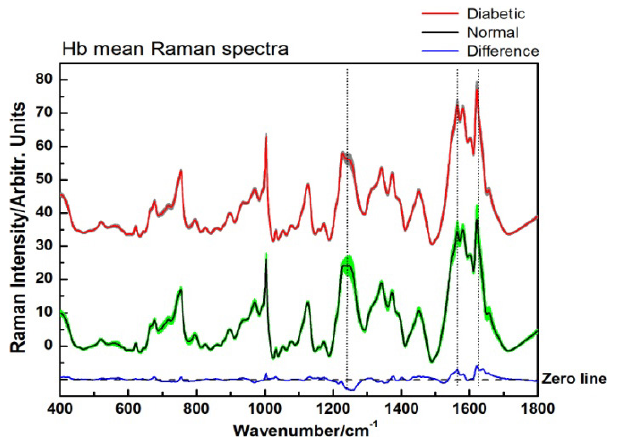
Fig. 2. (Color online) The normalized mean Raman spectra obtained from 39 diabetic blood Hb samples (red line) and 37 healthy blood Hb samples (black line), with the standard de- viations overlying as shaded color ¯ll. Also shown at the bottom is the di®erence spectrum. The vertical dotted line in the plot re°ects the main di®erence.